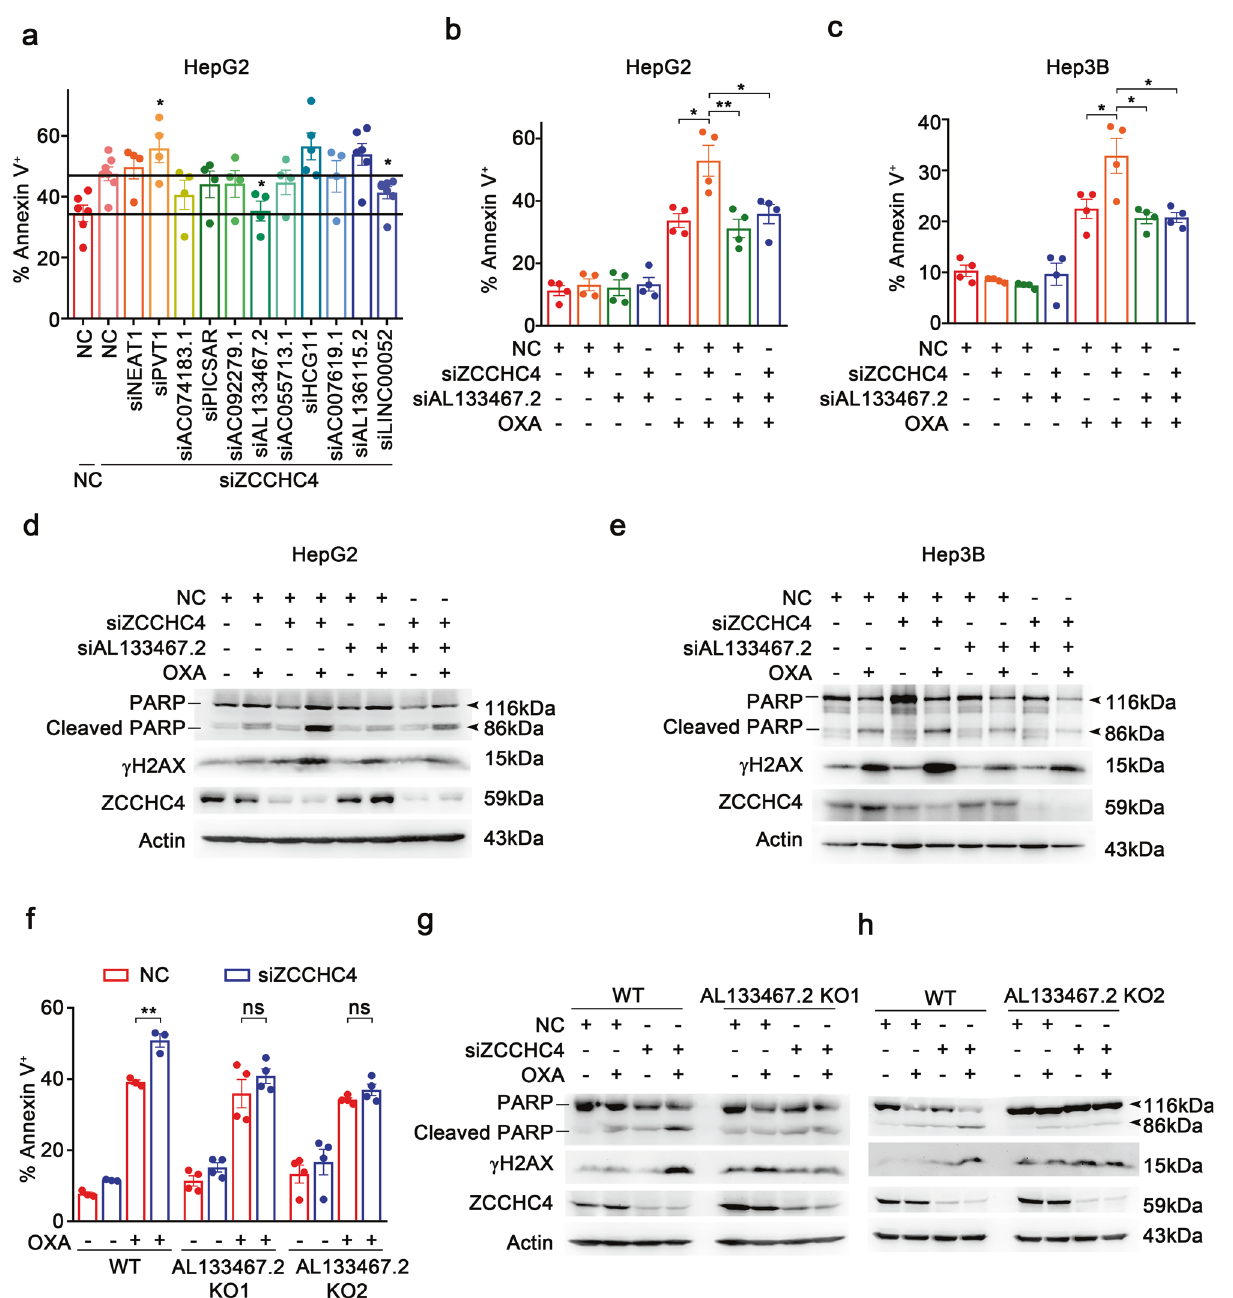
Fig. 5 ZCCHC4 hampers the pro-apoptotic function of AL133467.2 in OXA-treated HCC cells. a Flow cytometry analyzing OXA (62.5 µM, 36 h)- induced apoptosis of ZCCHC4 - and lncRNA- co-silenced HepG2 cells ( n = 4 – 7 per group). NC, non-speci fi c siRNA control. b , c Flow cytometry analyzing OXA (62.5 µM, 36 h and 62.5 µM, 48 h for HepG2 cells and Hep3B cells, respectively) -induced apoptosis of ZCCHC4 - and AL133467.2- co-silenced HepG2 cells ( b ) or Hep3B cells ( c ) ( n = 4 for ( b ) and ( c )). d , e Immunoblot analysis of OXA (62.5 µM, 16 h and 83.3 µM, 18 h for HepG2 cells and Hep3B cells respectively)-induced cleaved PARP and γ H2AX levels in ZCCHC4 - and AL133467.2-co-silenced-silenced HepG2 cells ( d ) and Hep3B cells ( e ). f Flow cytometry analyzing OXA (62.5 µM, 36 h)-induced apoptosis of NC- or ZCCHC4 - silenced WT cells or AL133467.2 KO cells ( n = 3 and n = 4 for WT and AL133467.2 KO group, respectively). WT wild-type. g , h Immunoblot analysis of OXA (62.5 µM, 16 h) -induced cleaved PARP and γ H2AX levels in NC- or ZCCHC4 - silenced AL133467.2 KO cells. Data are shown as mean ± s.e.m. a – c , f * P < 0.05; ** P < 0.01; ns not signi fi cant (unpaired Student ’ s t test). d , e , g , h One representative experiment of three is